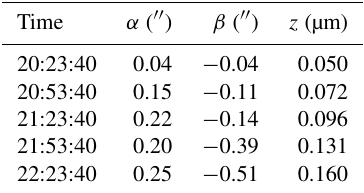
Table 4. Stability test results of α , β and z